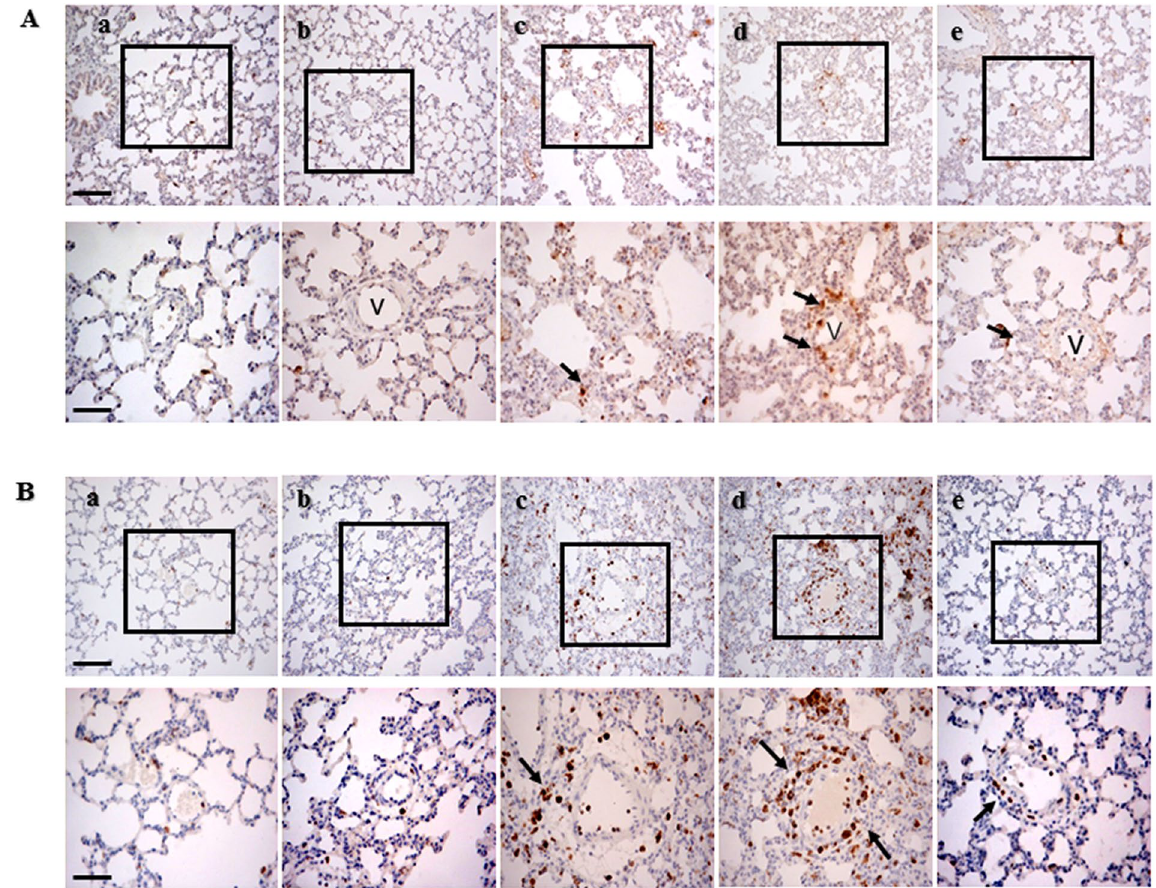
Figure 2. Effect of MHT post-treatment on infiltration of pulmonary neutrophils and macrophages. ( A ) Representative images of immunohistochemical staining for MPO to reveal neutrophils in Control (a), Control + MHT (b), Post-cold 6 h (c), Post-cold 24 h (d), Post-cold 24 h + MHT (e) group, respectively. Arrows indicate MPO positive cells. Bar = 100 μ m. The area within the rectangle in each image in upper panel is enlarged and presented below. Bar = 50 μ m. ( B ) Representative images of immunohistochemical staining for CD68 to reveal macrophages in Control (a), Control + MHT (b), Post-cold 6 h (c), Post-cold 24 h (d), Post-cold 24 h + MHT (e) group, respectively. Arrows indicate CD68 positive cells. v, microvessel. Bar = 100 μ m (upper panel) and 50 μ m (lower